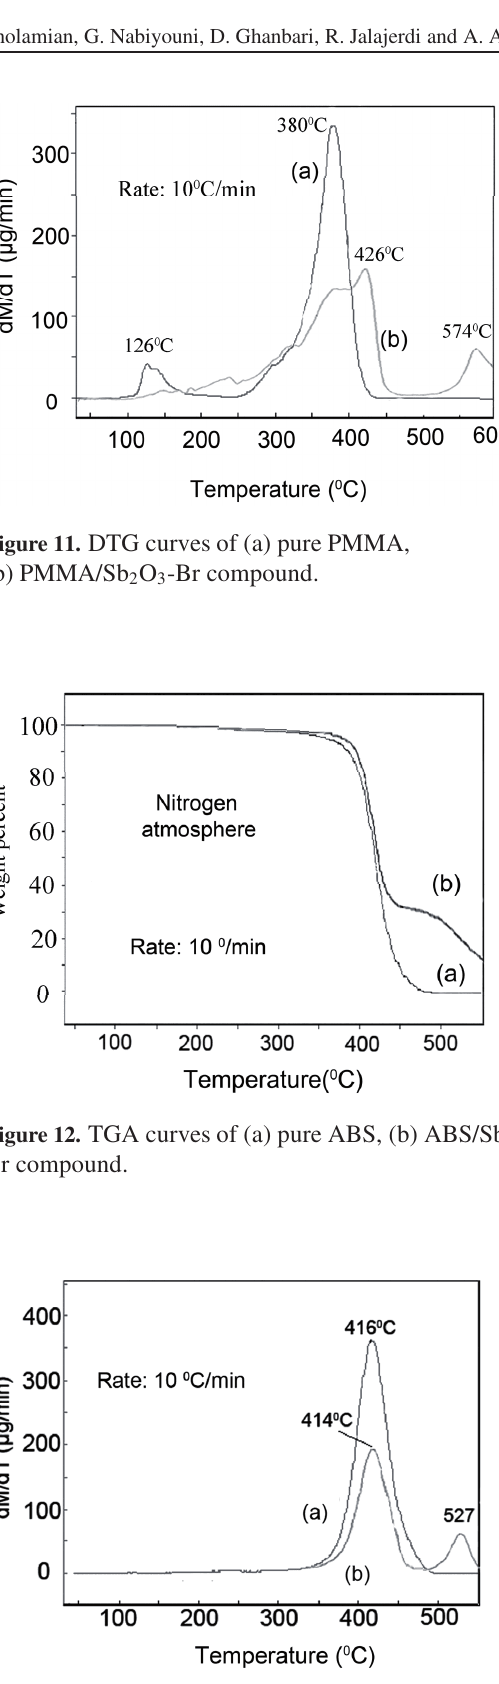
Figure 13. DTG curves of (a) ABS, (b) ABS/Sb 2 O 3 -Br